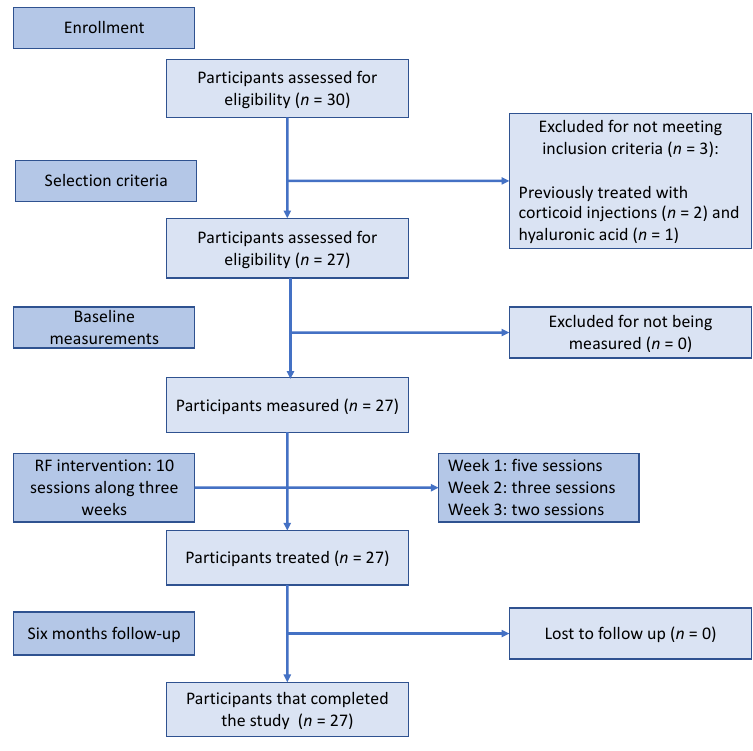
Figure 2 . Flow diagram of participants . Figure 2. Flow diagram of